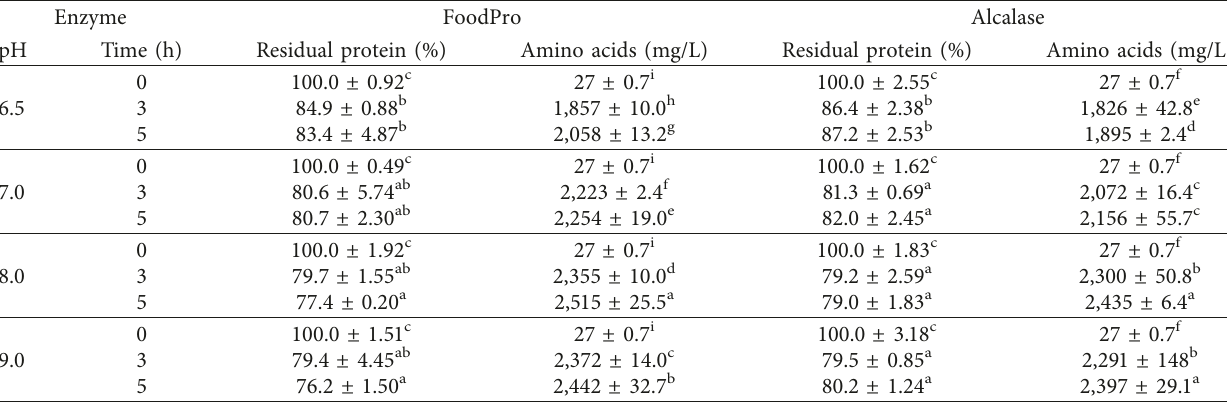
Table 3: Effects of pH on the enzymatic hydrolysis of regenerated silk fibroin using FoodPro and Alcalase at 60 ° C. Enzyme FoodPro Alcalase pH Residual protein (%) Amino acids